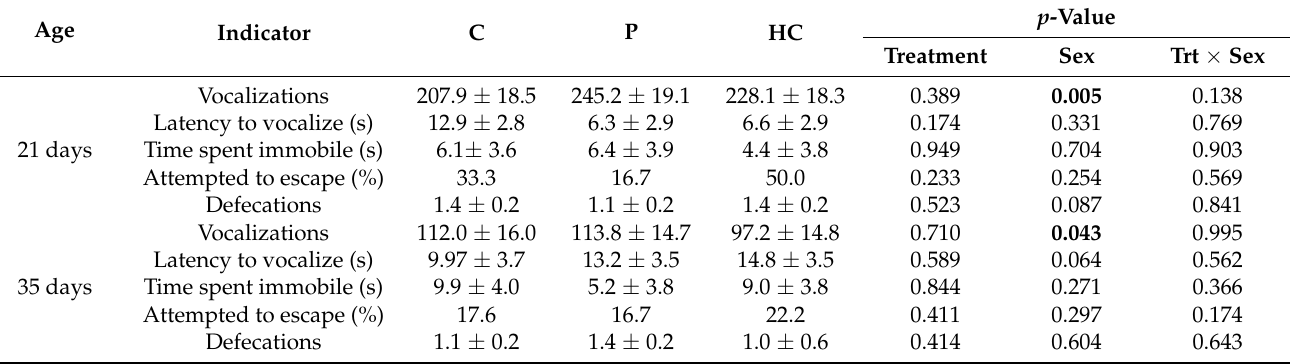
Table 4. Indicators of fearfulness (mean ± SEM or proportion of treatment group) during the open field test for chickens that were raised under standard conditions (Control; C); with additional physical items (P); or with additional human contact (HC). Bold font indicates significant p -values at p <